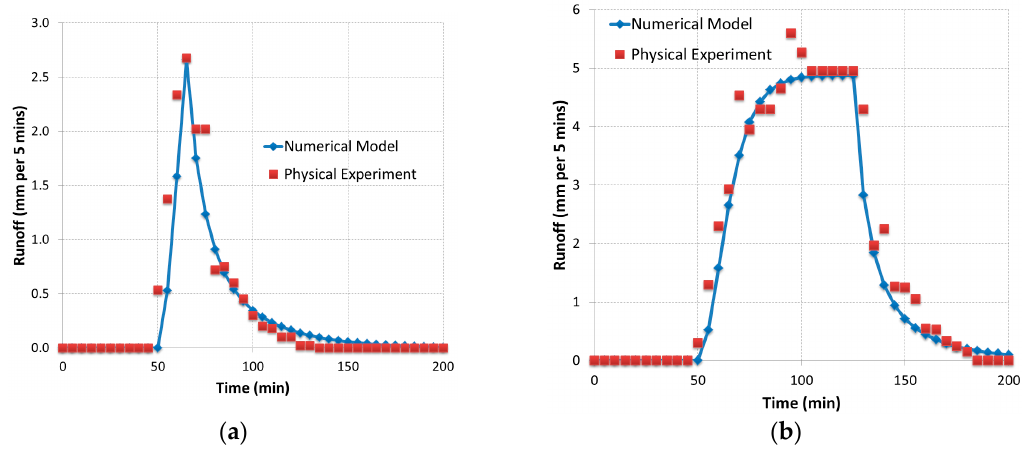
Figure 1. ( a ) Calibration and ( b ) validation of Treatment A. Table 4. Accuracy of calibration and validation.